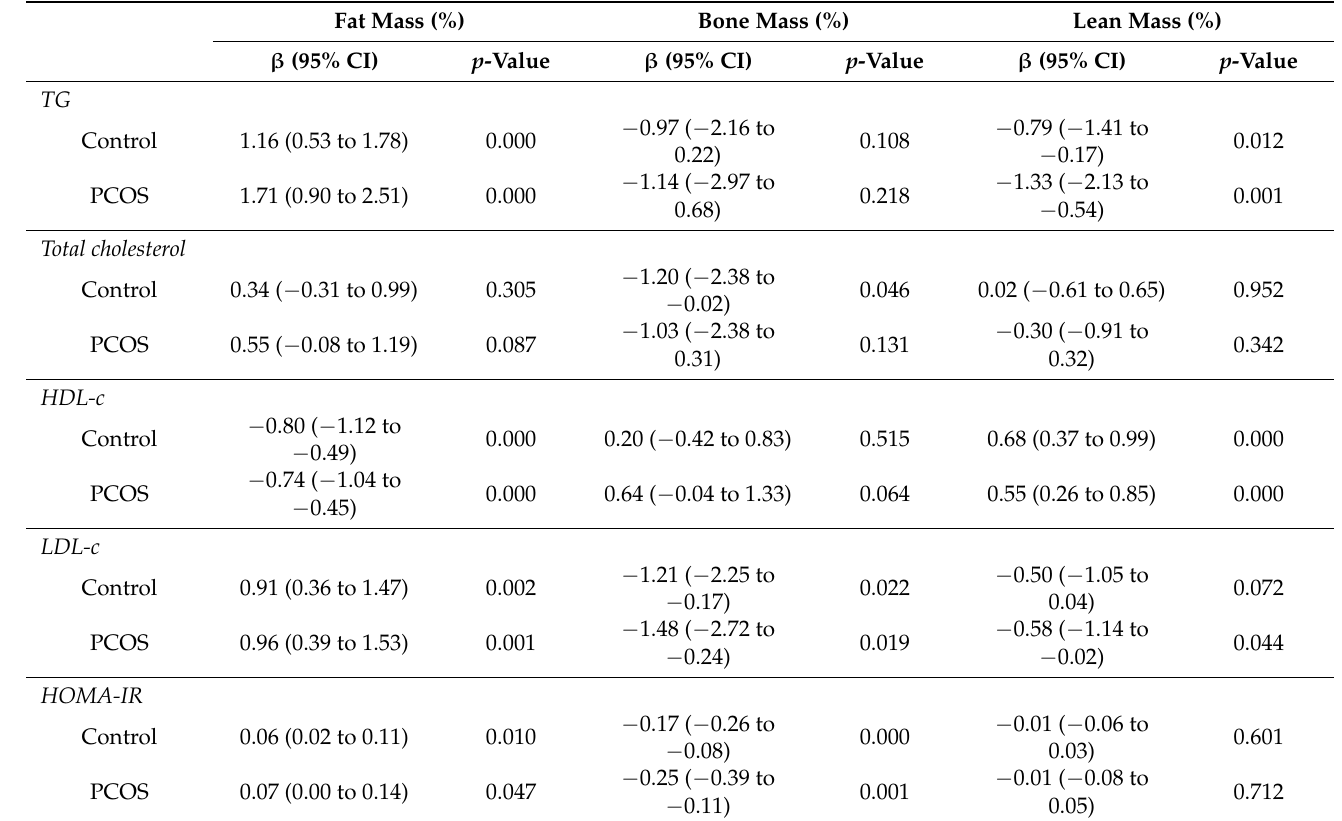
Table 2. Univariate linear regression analysis for individual body composition measures as predictors of lipid profile in the PCOS group and